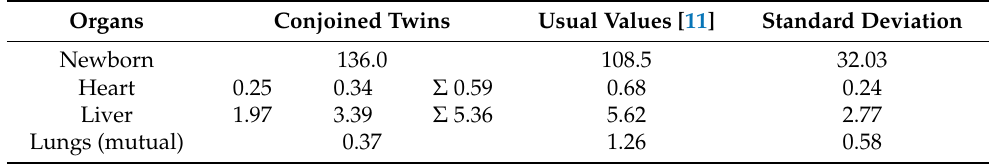
Table 1. Organ weight (g) of the conjoined twins and usual values of healthy newborn guinea pigs. Usual values for the described breed were obtained from ten newborns born dead. The bodies were dissected, and the organs were separated and